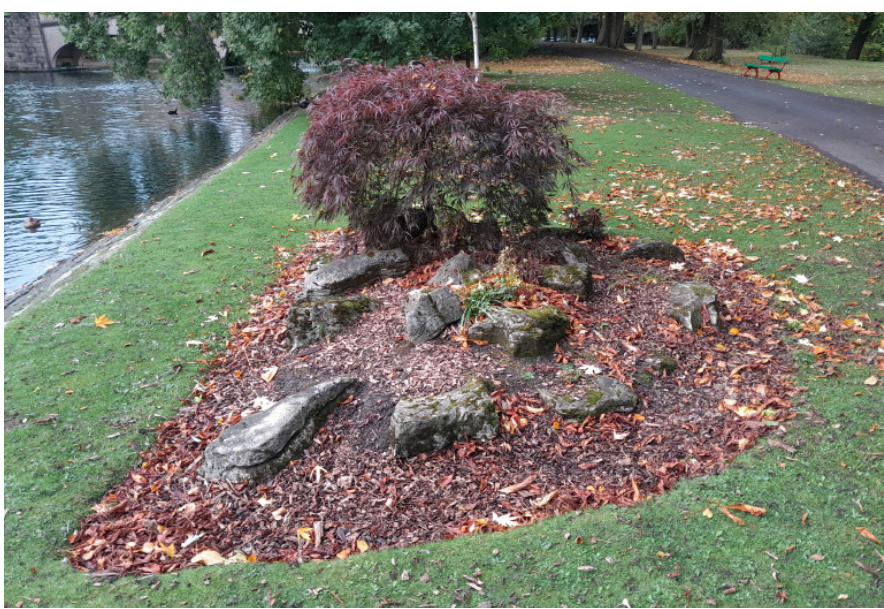
Figure 4. A smaller scale use of limestone pavement for ornamental purposes in Thompson Park,